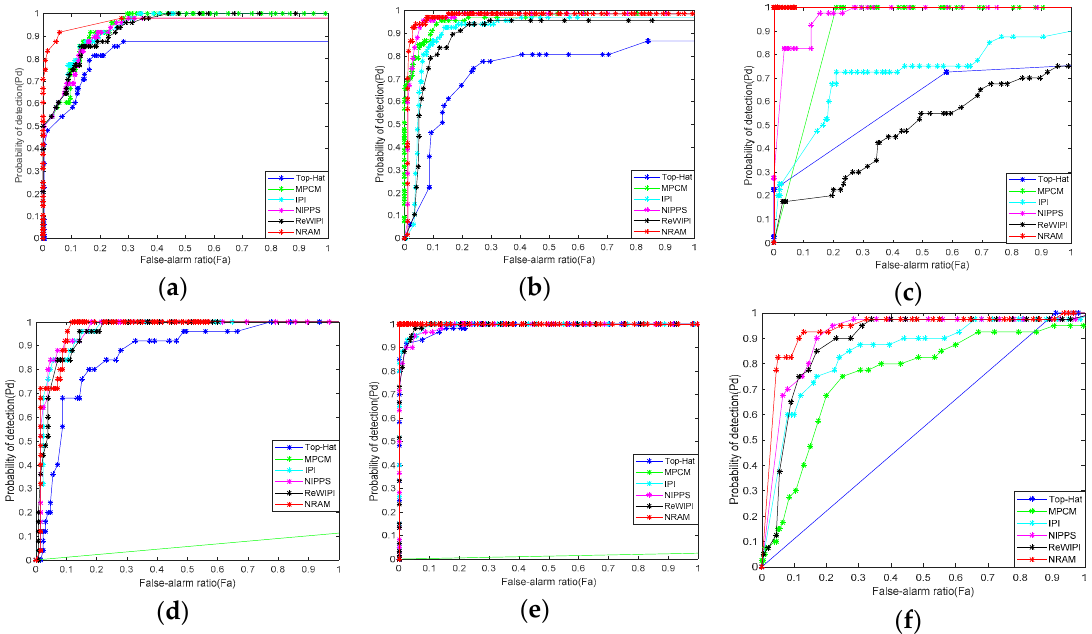
Figure 12. ROC curves of detection results of six real sequences. ( a ) Sequence 1; ( b ) Sequence 2; ( c ) Sequence 3; ( d ) Sequence 4; ( e ) Sequence 5; ( f ) Sequence 6.